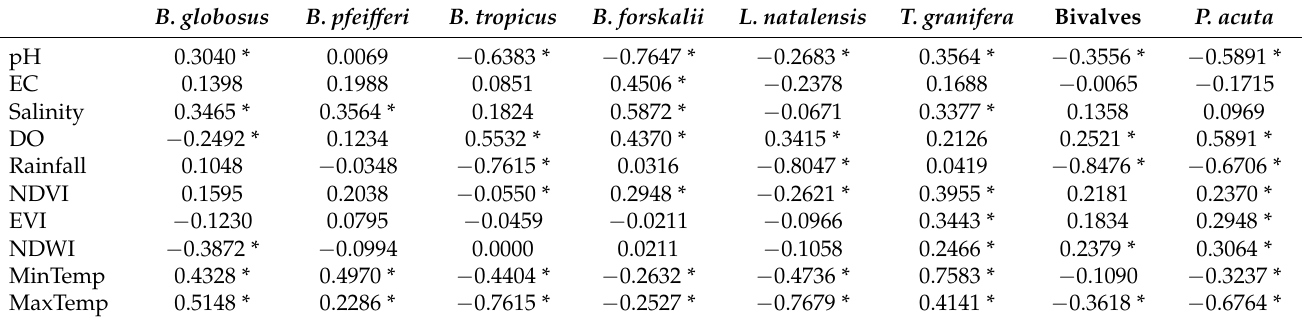
Table 5. Associations between snail abundance, physicochemical parameters, and climatic